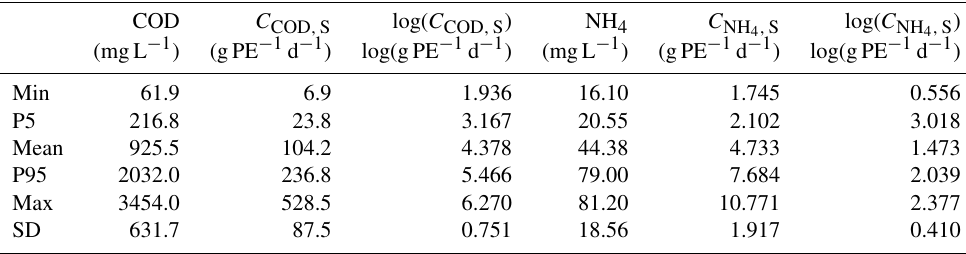
Table 3. Summary statistics of dry weather flow measurements for C COD , S and C NH